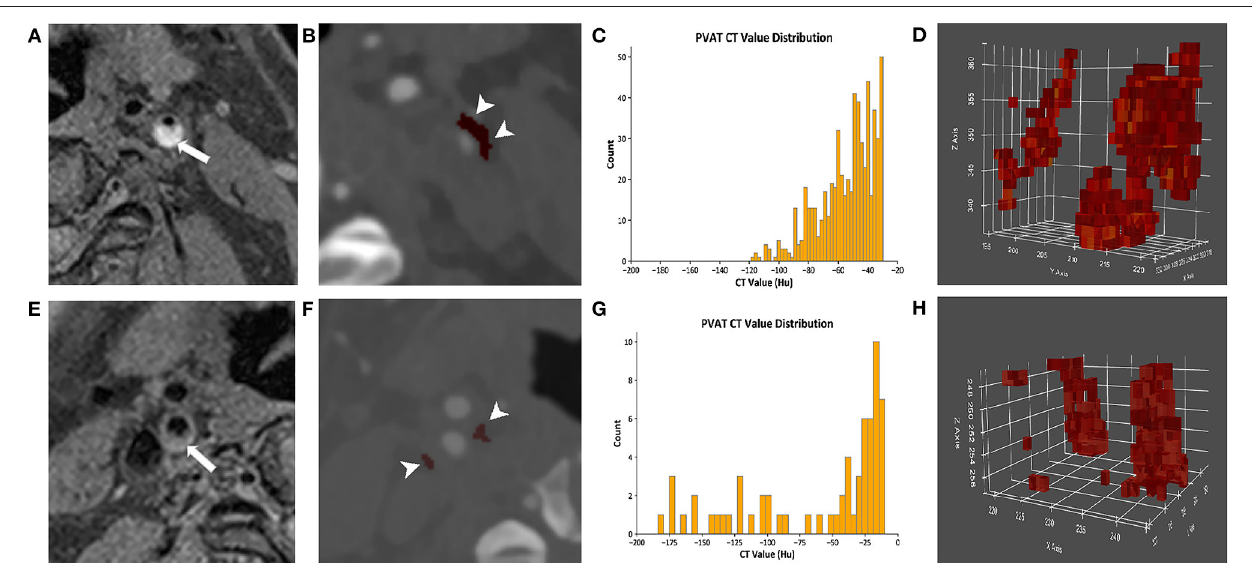
FIGURE 2 | The analysis of the PVAT of plaques with and without IPH. (A–D) Come from the same patient. (A) A presence of IPH (arrow) was identified on MRI. (B) The PVAT (arrowhead) surrounding carotid plaque with IPH was visualized on CTA by red pixels. (C) The histogram of PVAT density of plaque with IPH was shown. (D) The pixel diagram of PVAT density of plaque with IPH was shown. (E–H) Come from the same patient. (E) The plaques without IPH (arrow) were identified on MRI. (F) The PVAT (arrowhead) surrounding carotid plaque without IPH was visualized on CTA by red pixels. (G) The histogram of PVAT density of plaque without IPH was shown. (H) The pixel diagram of PVAT density of plaque without IPH was shown. PVAT, perivascular adipose tissue; IPH, intraplaque hemorrhage.